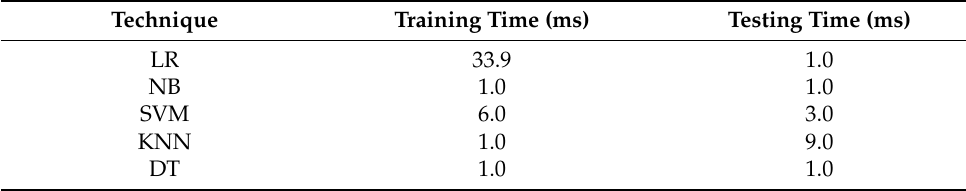
Table 4. Comparison of training and testing time.